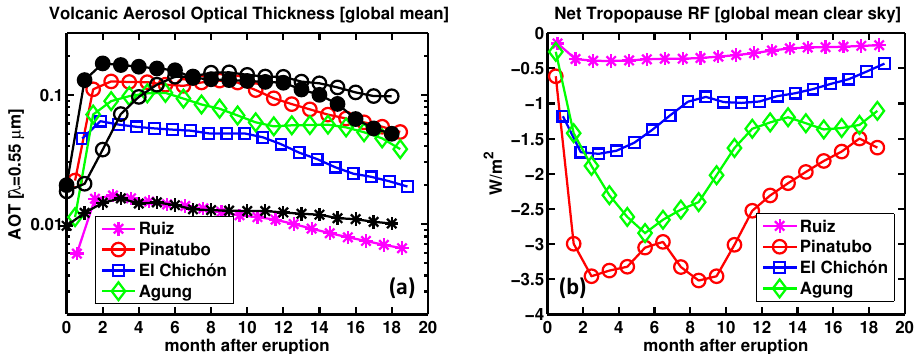
Figure 12. Panel ( a ) time series of the calculated global mean optical depth of volcanic aerosols (see legend). Black asterisks show SAGE-II values for the Ruiz eruption; black open and filled-up circles show post-Pinatubo values from SAGE-II [65] and AVHRR [23], respectively. Background values were removed from AVHRR observations (see text). Panel ( b ) time series of the calculated net tropopause RF due to the volcanic aerosols (global mean for clear sky conditions) (W/m 2